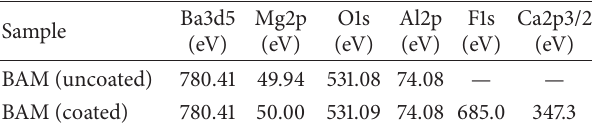
Table 1: Binding energies of the elements of uncoated and coated BAM phosphor